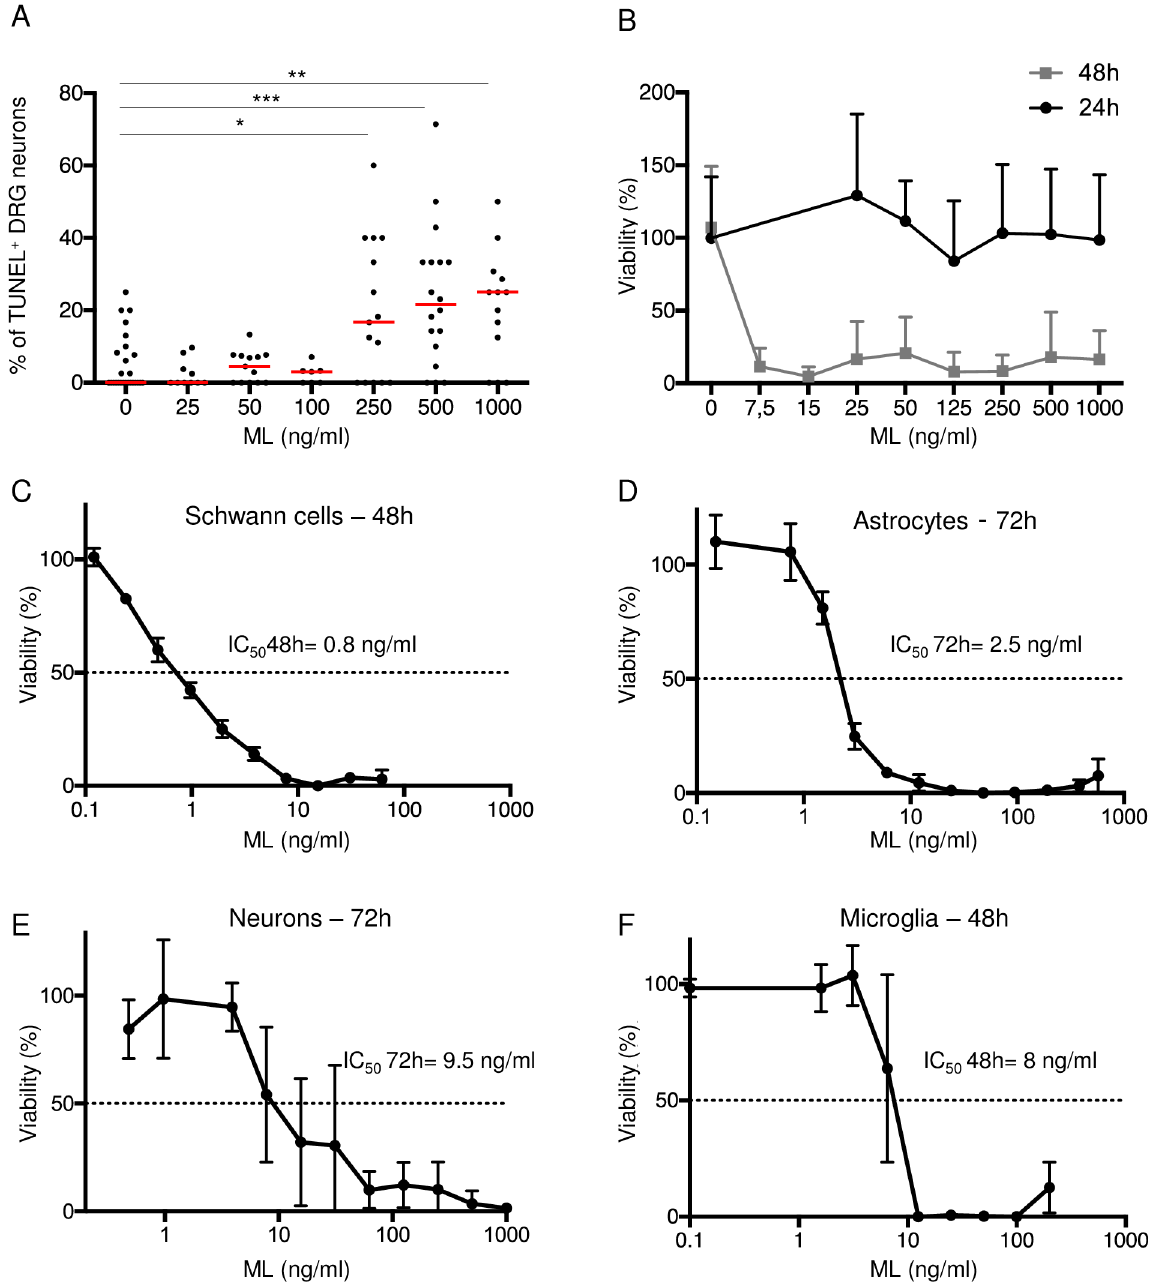
Fig 1. Cytotoxicity of mycolactone on PNS and CNS cell subsets. (A-B) Cytotoxicity of mycolactone (ML) on dorsalroot ganglion (DRG) neurons, identifiedby β -III tubulin staining.(A) Proportionof TUNEL + DRG neurons, relativeto the total numberof DRG neurons, after 24 h of exposureto increasingdoses of ML. Red lines indicatemean percentages. Data are from two independent experiments, with at least 10 acquisitionfields per dose, and 200 cells per dose. Statistics: Mann whitney, * p < 0.05, ** p < 0.01, *** p < 0.001.(B) Viability of DRG neuronsafter 24 or 48 h of exposure to ML expressedas percentagesrelative to vehicle-treated controls. Data are from two independentexperiments, with at least 10 acquisitionfields per dose, and 200 cells per dose (C-F) Cell viability, as assessedby MTT reduction, of primary mouse Schwanncells incubatedwith ML or vehicle for 48 h (C), primary cortical astrocytes for 72 h (D), cortical neuronsfor 72 h (E) and microgliafor 48 h (F). IC 50 indicatesthe concentration of ML leading to 50% cell death, comparedto vehicle-treated controls. Data are mean percentages ± SD of triplicates, and are representativeof three independentexperiments.